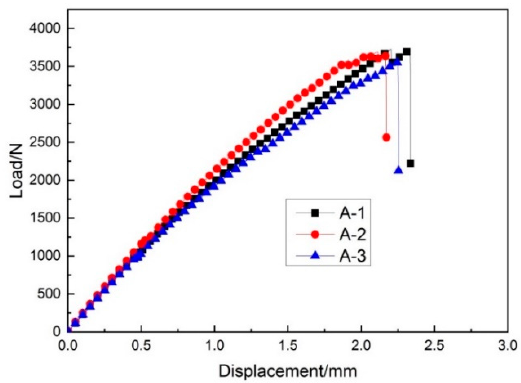
Figure 20. Warp tensile load–displacement curve of sample group A.